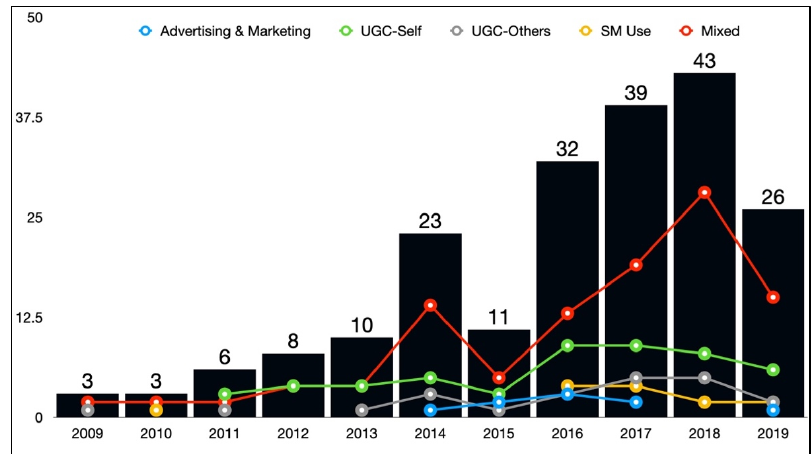
Figure 2. Frequency of alcohol ‐ related social media studies, by year and study focus type.